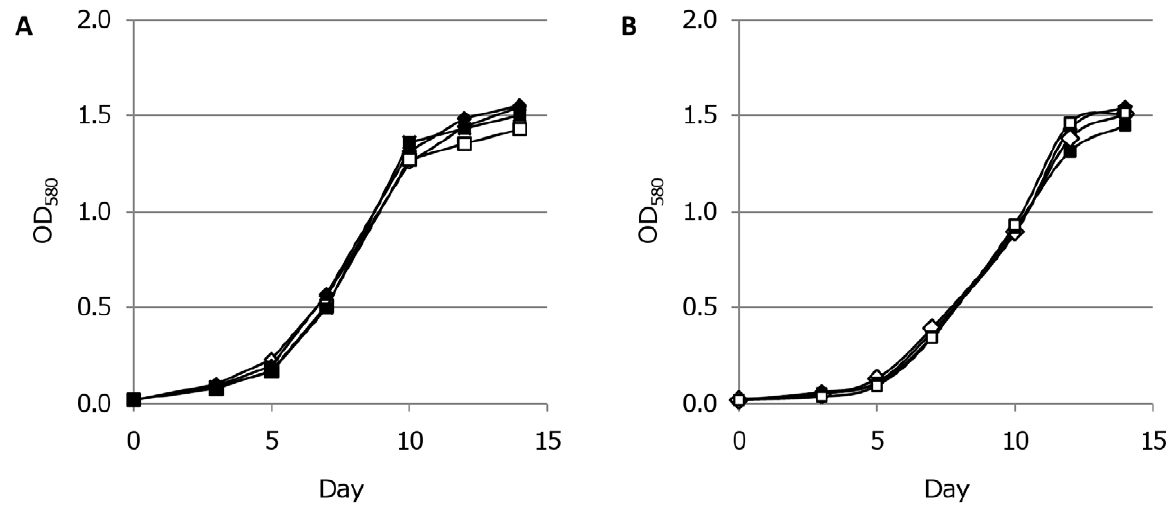
Figure 9. Growth kinetics of M.tuberculosis reporter strains. M. tuberculosis transformants were grown in liquid medium in the (A) presence or (B) absence of hygromycin. e pSMT3 empty vector control; % tdTomato expressed from P smyc ; D Turbo expressed from P smyc ; & mCherry expressed from P hsp60 and ¤ mCherry expressed from P smyc . Data are the averages from three independent transformants.